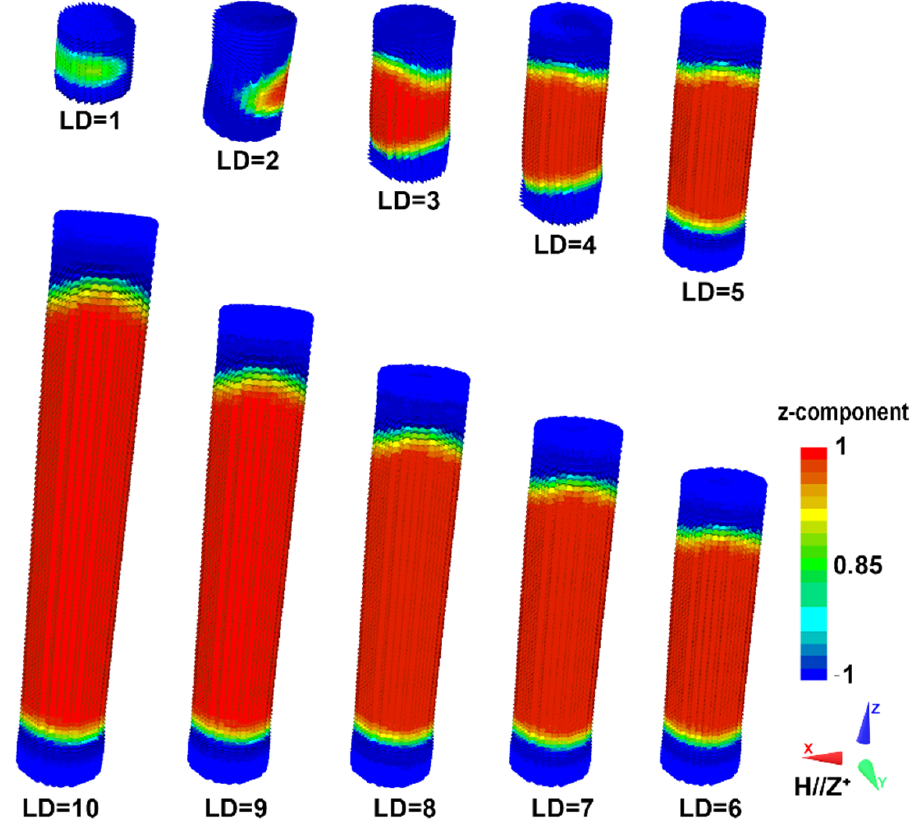
Figure 5. Vector maps of magnetization structure close to the coercivity of core/shell cylinders with different aspect ratios L / D . The thickness of the soft magnetic shell is 3 nm. The coordinate system and color map indicating the direction of the magnetization are shown next to the image. As mentioned above, the coercivity increases with the aspect ratio, but this effect fades away when the aspect ratio reaches a critical value. The static magnetic behavior of the ellipsoid sets the upper limit of the shape anisotropy coefficient, which helps understand the correlation between the aspect ratio and the shape anisotropy, even the coercivity of the present core/shell cylinders. If no other anisotropy is considered, the magnetic shape anisotropy energy is the total demagnetization energy. In the configuration of the ellipsoid ( c > a = b , where a , b , and c are the ellipsoid semi-axes), the coercivity is simply proportioned to the N a - N c , where N c and N a are the demagnetization factors, and satisfying